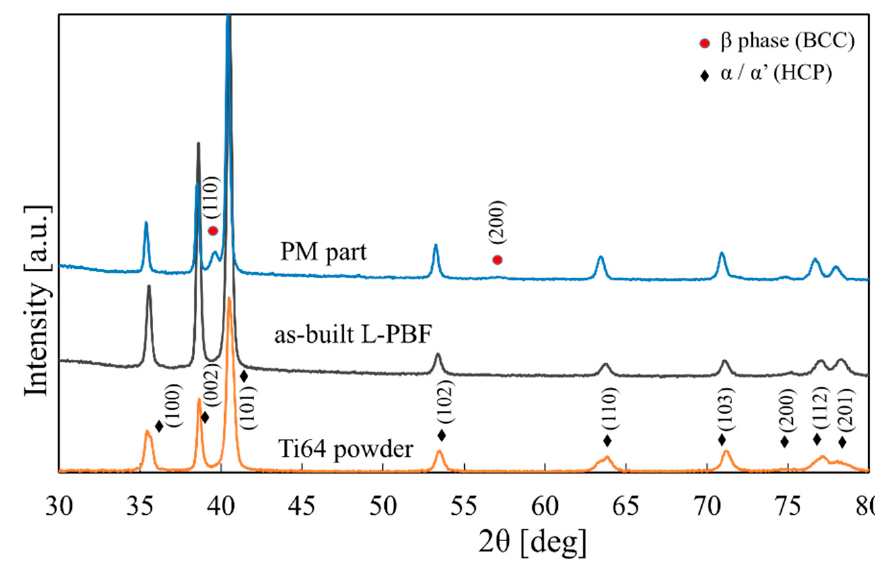
Figure 6. XRD spectra of Ti64 powder, as-built L-PBF, and PM sample.